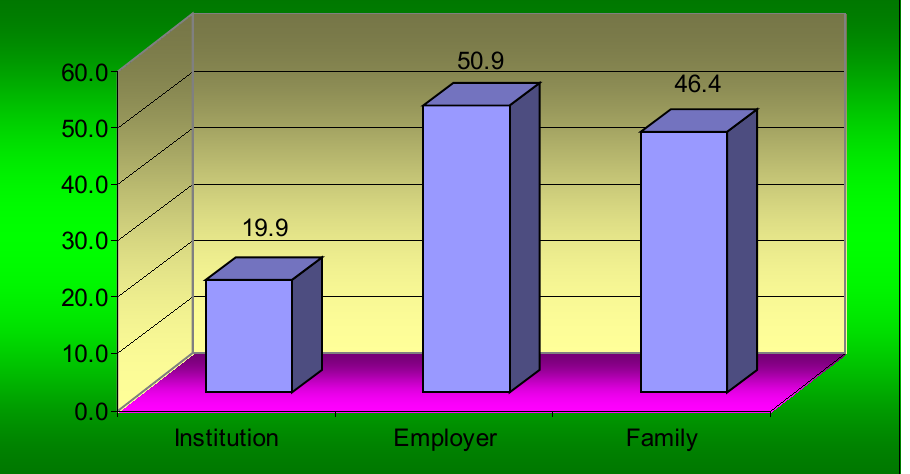
Figure 2. Who pays the cost of using the Internet?